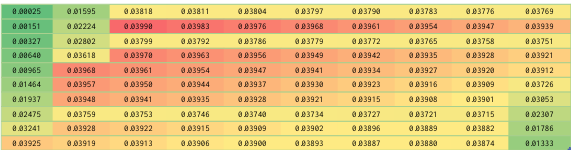
Table 6. Maximum distances of the fitting straight lines on the right image of the GeoEye dataset (pixel)